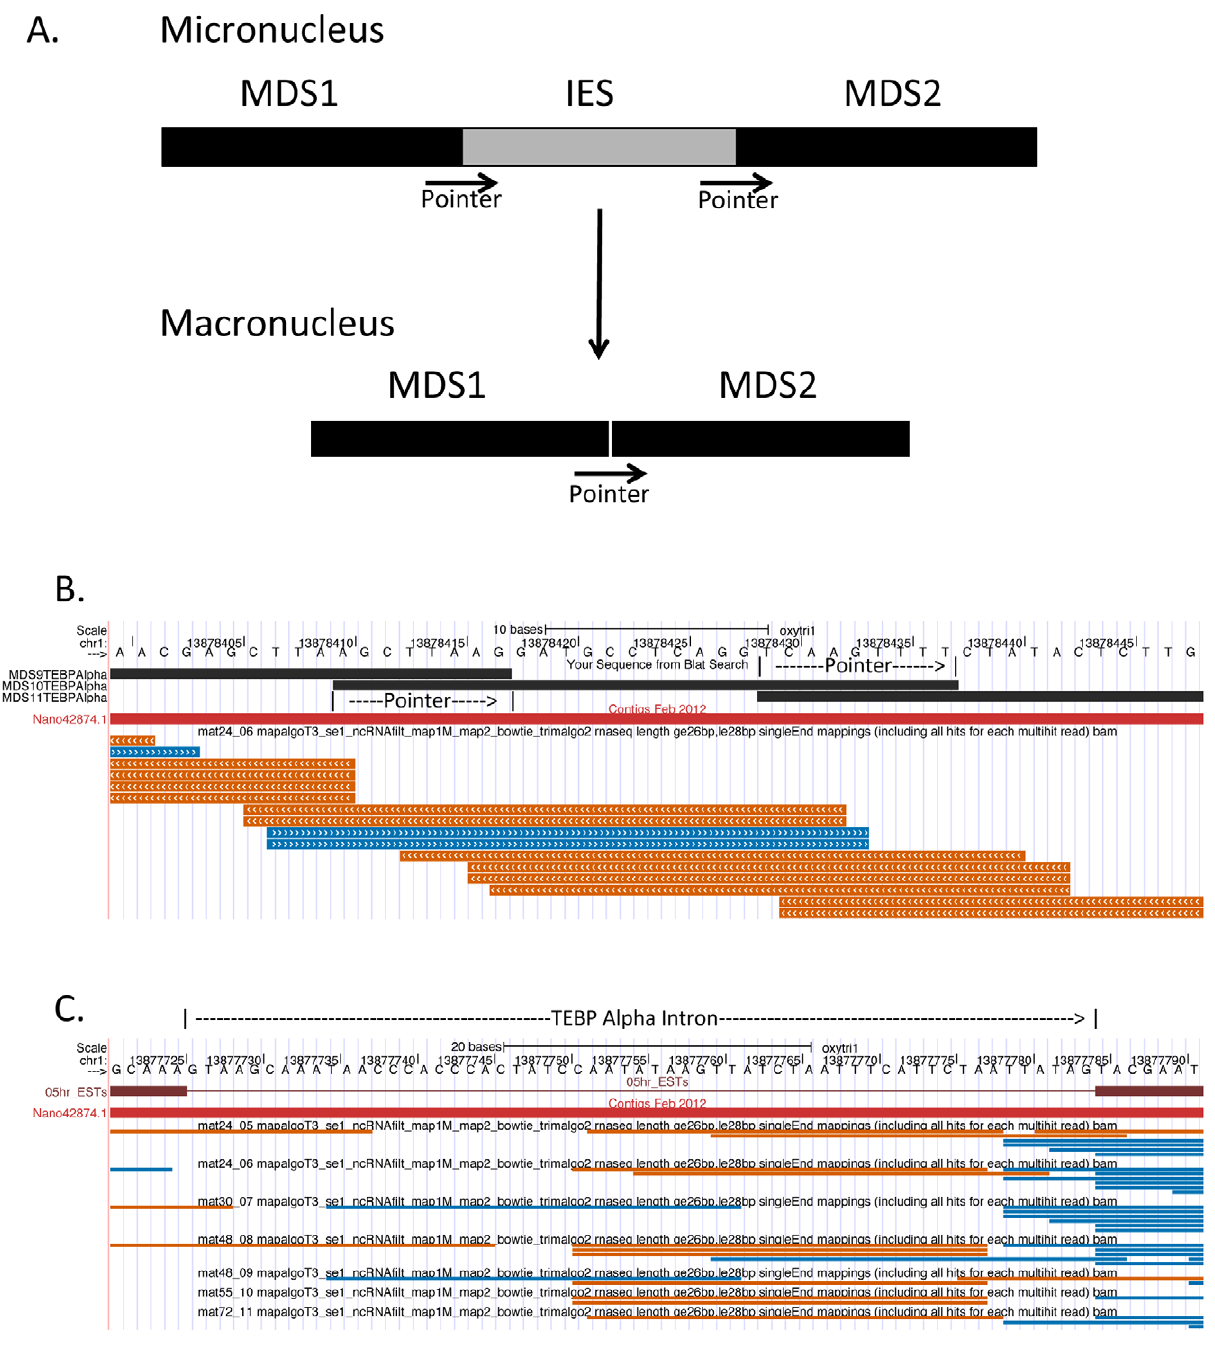
Figure 8. 27 nt small RNAs are macronuclear in origin and do not require intron removal for their generation. A . Schematic diagram of internally eliminated sequence (IES) removal and macronuclear destined sequence (MDS) joining during macronuclear development. Pointer sequences are direct repeats found in the micronucleus at MDS borders. Only one copy of the pointer is found in the macronucleus. B . Oxytricha trifallax Macronuclear Genome Browser screen shot of a region of the alpha telomere binding protein gene showing the junctions and overlapping pointer sequences of MDSs 9, 10 and 11. Only the mat24_06 library 26–28 nt small RNA track is shown. Note that the 26–28 nt small RNAs from the mat24_06 library from both strands overlap the MDS junction and pointer sequences. This is consistent with these small RNAs having originated from the mature parental macronucleus. C . Screen shot of a region of the alpha telomere binding protein gene containing its intron. 26–28 nt small RNAs from all seven mating libraries are shown. Note that sense strand small RNAs are found within the intron, indicating that they could be processed from introns. Also, small RNAs in the sense strand are found crossing the downstream intron/exon border, indicating that these are made from an RNA that did not undergo intron processing.